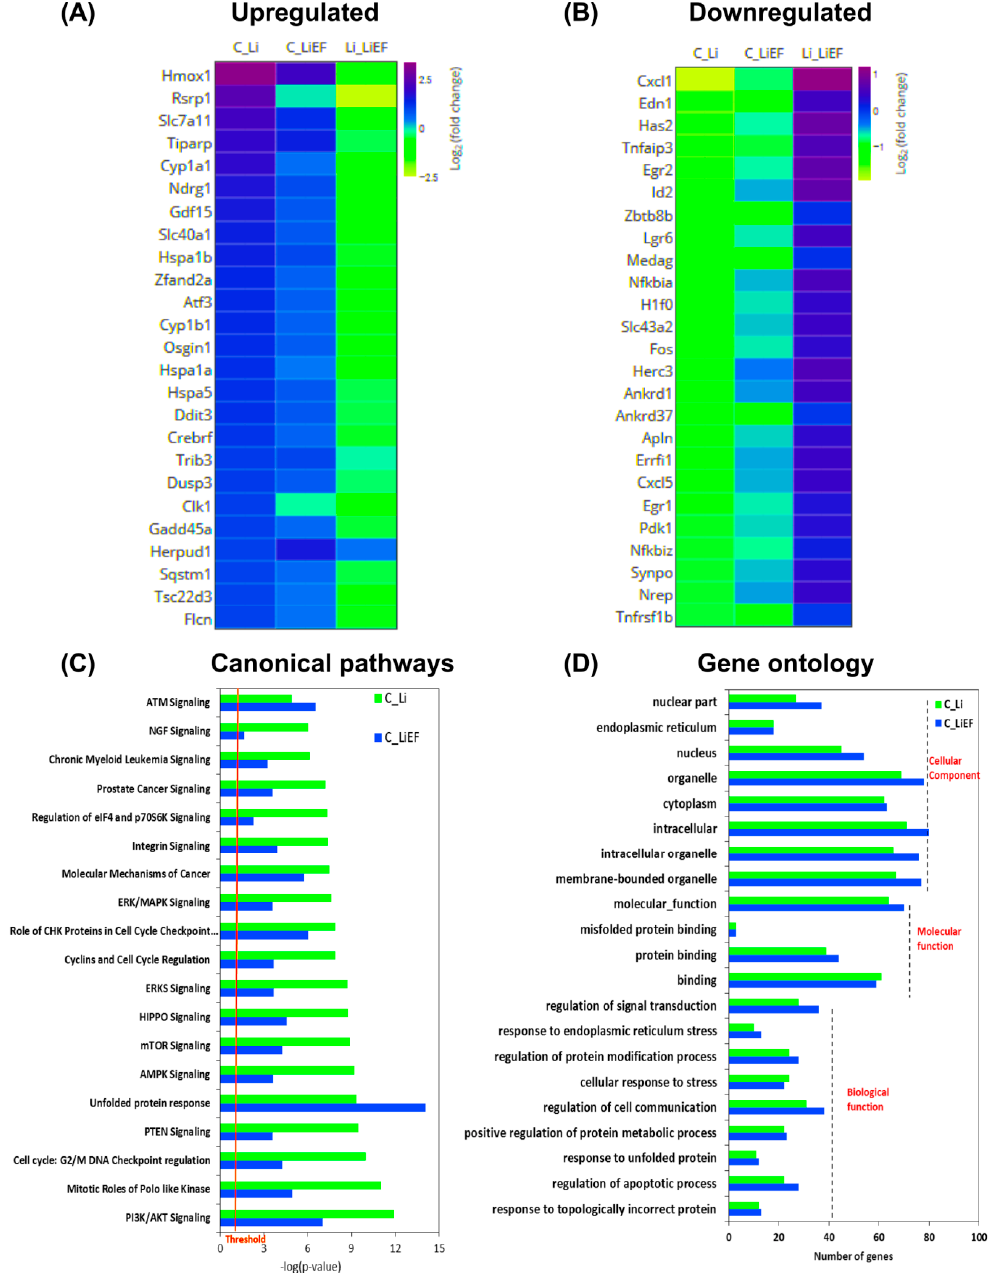
Figure 5. Pathway analysis and Gene ontology (GO) of differentially expressed genes (DEGs). ( A , B ) Heat map of top 25 upregulated and downregulated genes based on log 2 (fold change) generated using graphical user interface Plotly. ( C ) Top canonical pathways derived from ingenuity pathway analysis (IPA) software upon core analysis (cut off p value of 6). Threshold represents the minimum significance level (scored a − 1log( p -value) from Fisher’s exact test, set here to 1.25). ( D ) The functional enrichment of top 100 upregulated proteins in the interaction network was carried out in STRING 10.5 database web browser. Red font means the category of cell biological function. Only the top few most significantly enriched GO terms in each GO category (Biological Process, Cellular Component and Molecular function) were presented. Horizontal axis represents the number of genes. A GO term was considered significant at p -value < 0.01. (Number of experiments = 3).